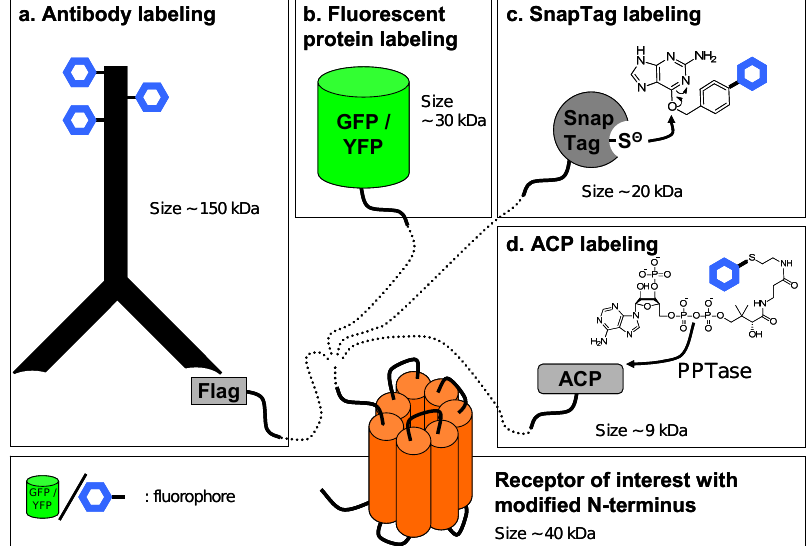
Figure 3. Labeling techniques for G-protein coupled receptors modified at their N- terminus. (a) Labeling with an antibody directed against an epitope; (b) Fusion of a fluorescent protein to the receptor; (c) SnapTag labeling of the receptor by fusion of a SnapTag suicide enzyme and addition of a fluorescently-labeled substrate (benzyl- guanine); (d) ACP labeling by fusion of an ACP epitope to which binds part of fluorescent coenzyme-A catalyzed by